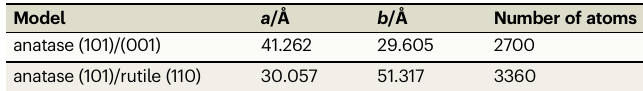
Table1 |Calculated latticevectors and thenumber ofatoms in the periodic interface slab models used to obtain E int values Model a /Å b /Å Number of atoms anatase